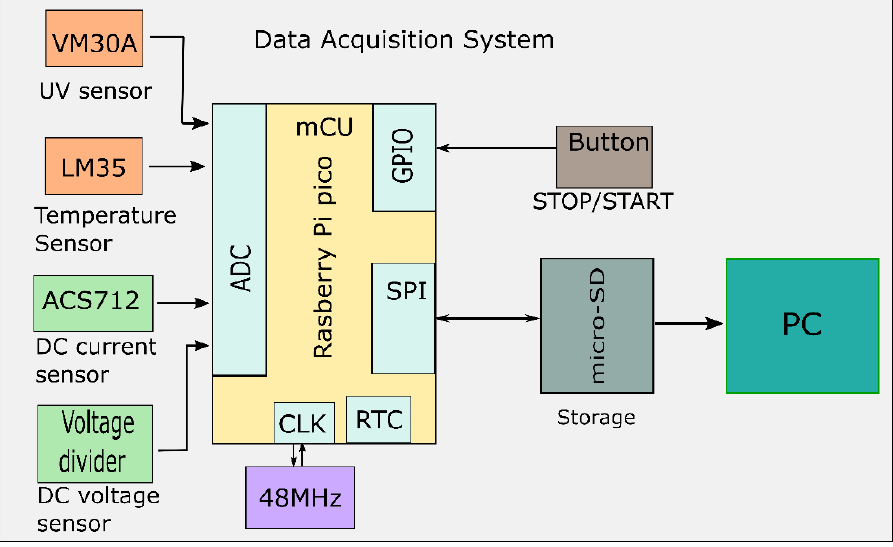
Figure 5. Overview of the DAS.